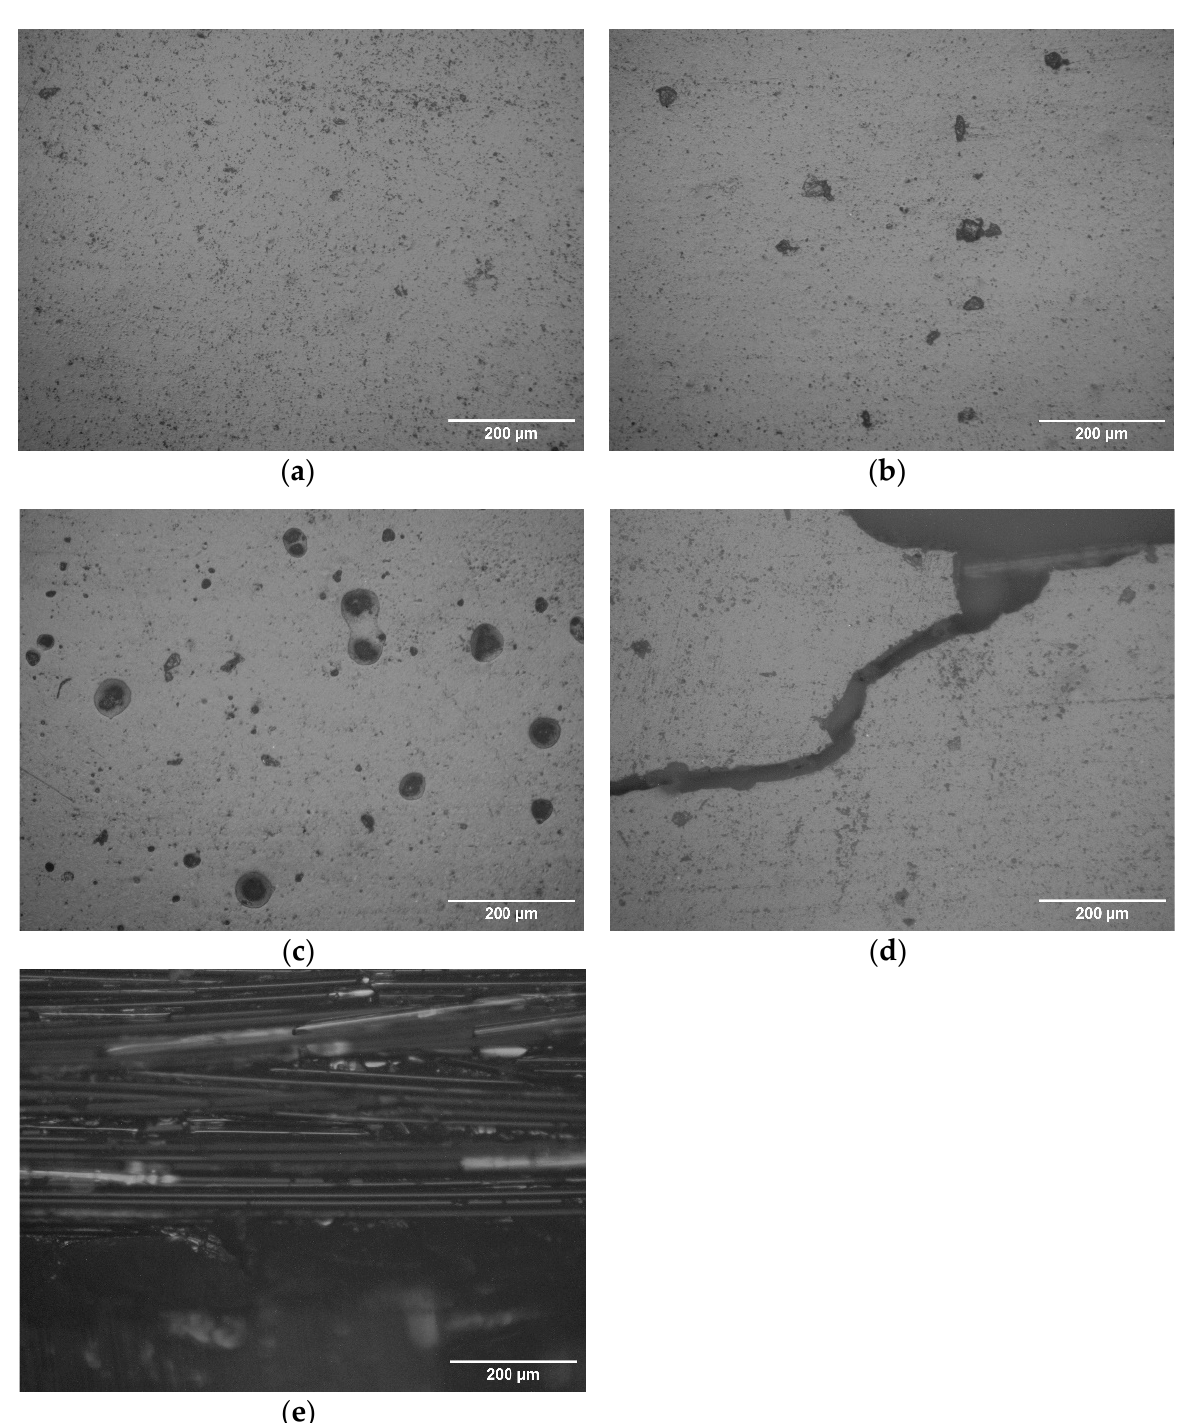
Figure 9. Microcopy image of representative sample with coating A at ( a ) stage 1; ( b ) stage 2; ( c ) stage 3; ( d ) stage 4; ( e ) stage 5.